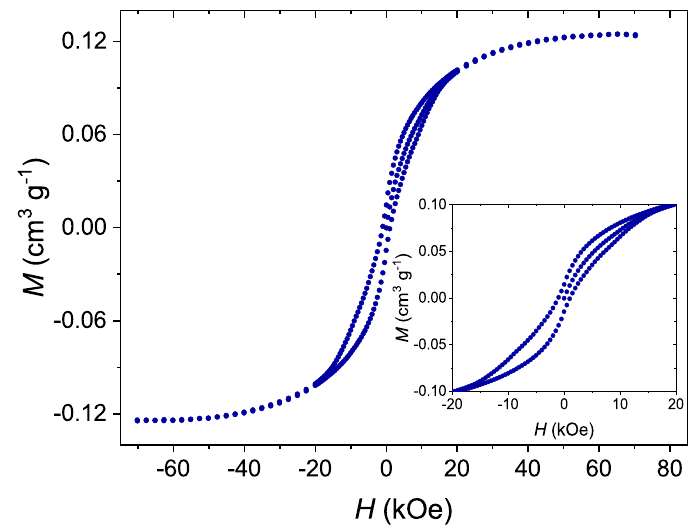
Figure 5. The dependence of magnetization on magnetic field for Mn 12 -stearate single-molecule magnets attached to the surface of spherical silica measured at a temperature of 2 K.